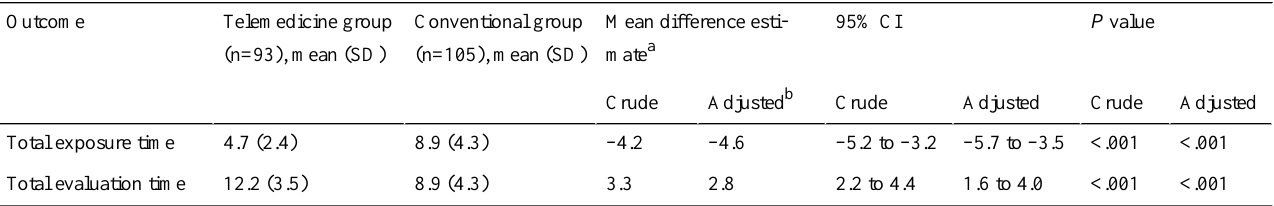
Table 2. Estimates of the crude and adjusted mean differences in the total evaluation time and total exposure time in minutes between the telemedicine and conventional